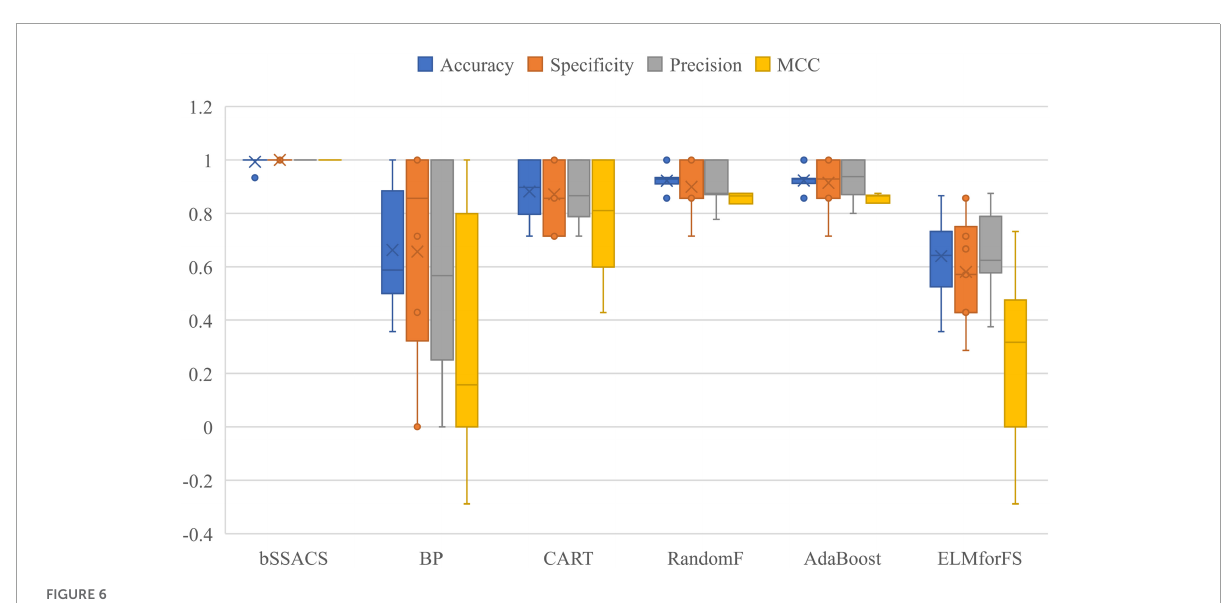
FIGURE6 Comparison results of SSACS-KELM with other classical